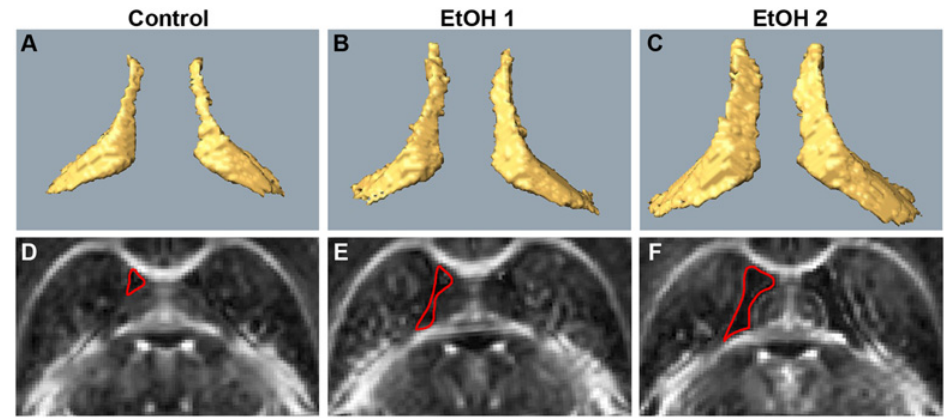
Fig 6. 3D visualization of the ventricular volumes of control and ethanol-exposed mice (P60). The top panel shows lateral ventricles of a control (A) and two ethanol-exposed mice (B and C). Fractional anisotropy maps of the same animals are shown in the panel below (D-F). Red line outlines the left ventricle.